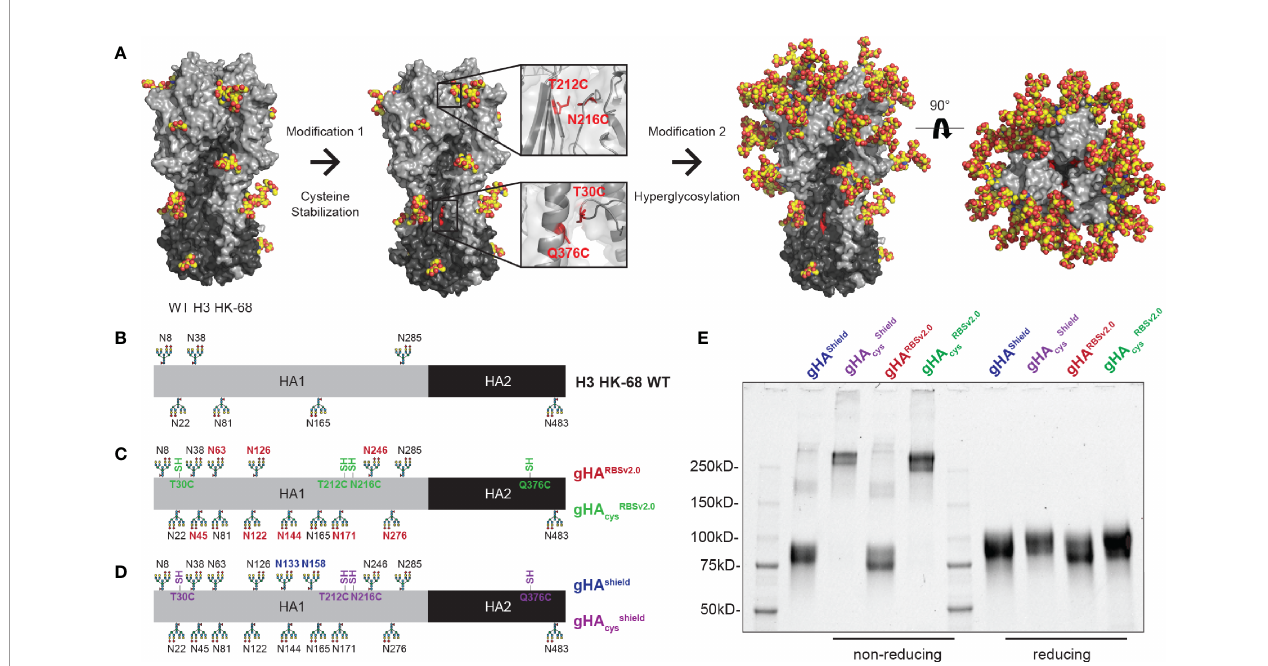
FIGURE 1 | Design of second-generation hyperglycosylated hemagglutinin (gHA) immunogens with interface disul fi de stabilization mutations. (A) Structural representation of H3A/Hong Kong/1/1968 (H3 HK-68) HA (PDB: 4FNK) with trimer-stabilizing interface cysteine mutations at residues 30, 212, 216, and 376, and additional surface glycans. (B) Linear representation of wild-type (WT) H3 HK-68 with native glycosylation sites marked. (C) Linear representation of gHA RBSv2.0 and gHA cysRBSv2.0 with additional glycans relative to WT marked in red, and cysteine stabilizing mutations marked in green. (D) Linear representation of gHA Shield and gHA cysshield with additional glycans relative to WT marked in blue, and cysteine stabilizing mutations marked in purple. (E) SDS-PAGE biochemical analysis of gHA immunogens under non-reducing and reducing conditions. Cysteine stabilized mutants show predominantly trimeric bands under non-reducing conditions (left) that collapse back to monomeric bands under reducing conditions